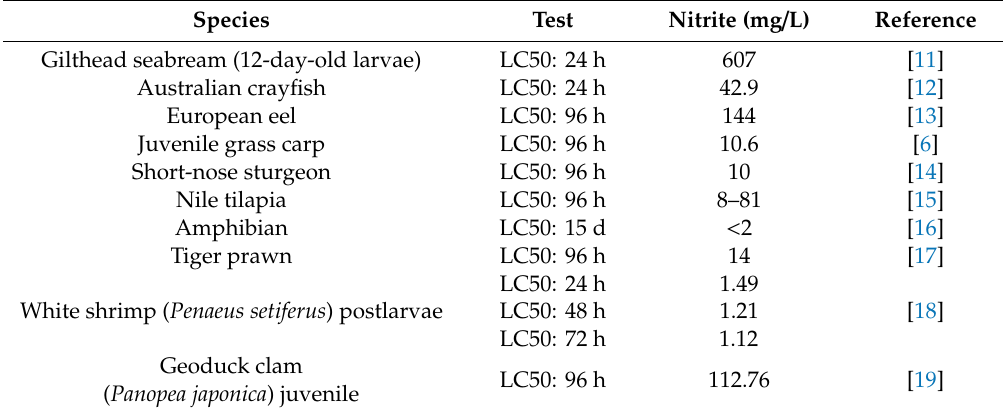
Table 1. Examples of the nitrite toxicity to aquatic